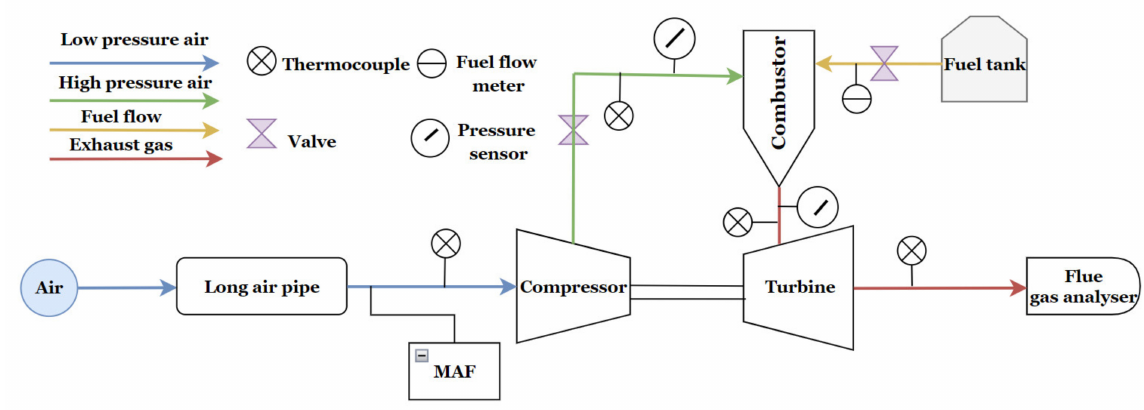
Figure 14. The schematic drawing of the test rig setup.